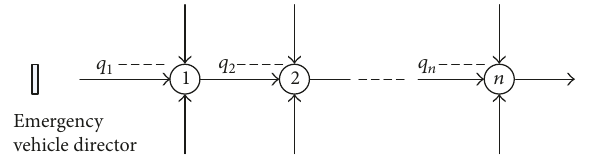
Figure 1: Diagram of intersection.